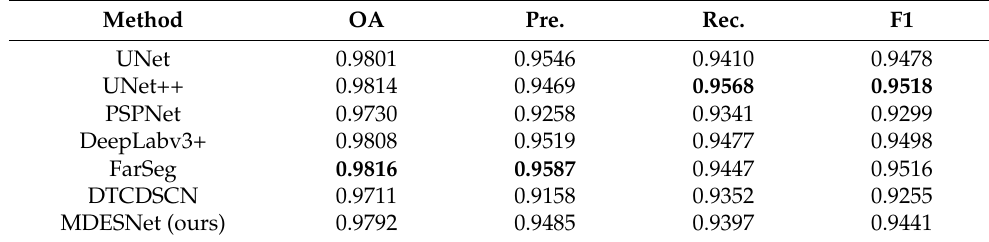
Table 5. Comparative study of several semantic segmentation methods on the BCDD dataset.